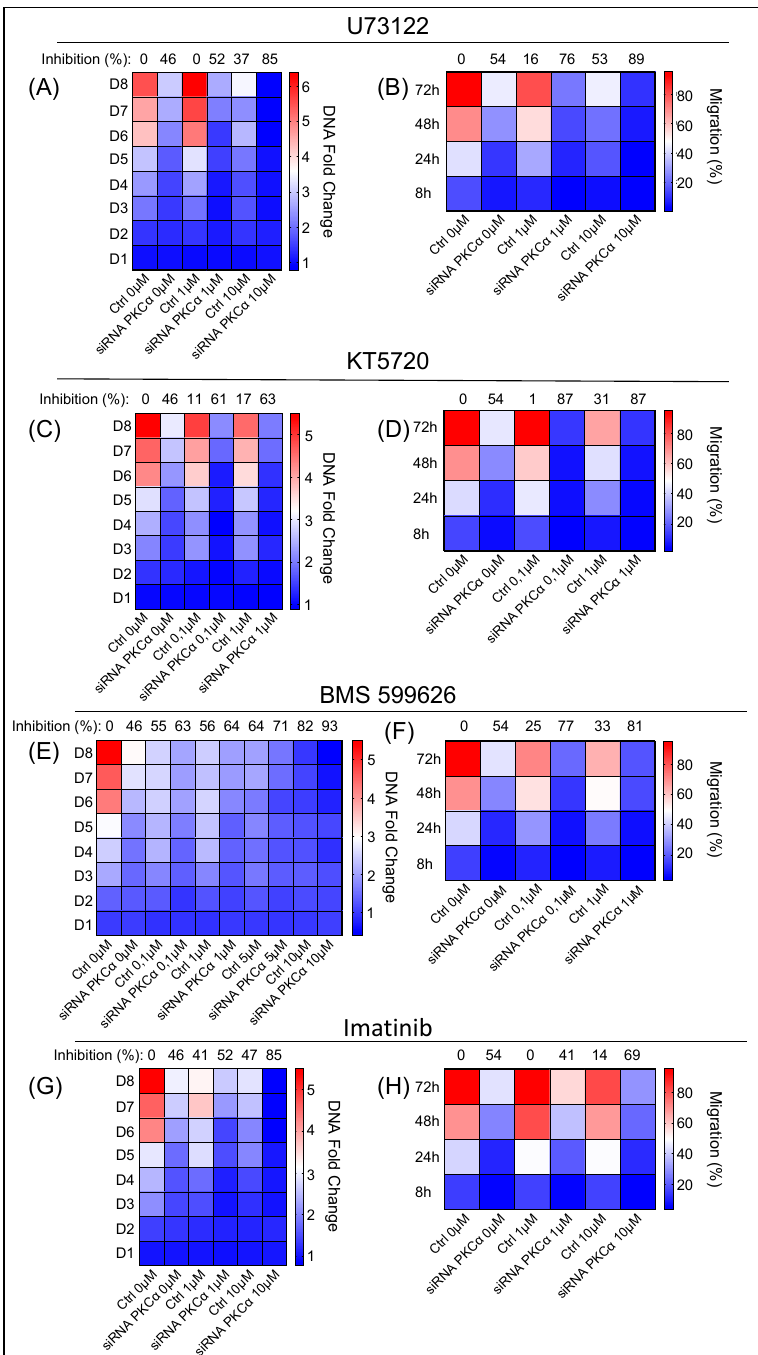
Figure 6. Effect of additional inhibition of the key signaling pathways identified in the arrays. The proliferation and migration capabilities of PKC α -WT and PKC α -KD MCF-7 cells were measured under different treatments: ( A , B ), U73122; ( C , D ), KT5720; ( E , F ), BMS 599626; ( G , H ), Imatinib on PKC α -WT and PKC α -KD MCF-7 cells. A heat map-type graph was used with the dark blue color corresponding to the lowest value for the DNA fold change or migration % and the dark red color to the highest value. The effect of each treatment on PKC α -KD vs. PKC α -WT MCF-7 cells at day 8 (proliferation assay) or 72 h (migration assay) is shown at the top of the heat map as the percentage of inhibition on the ability to proliferate or migrate.